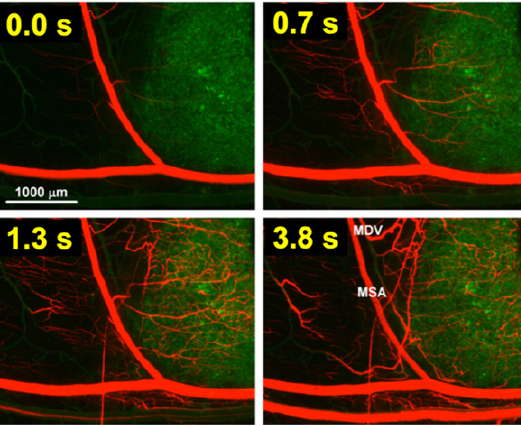
Figure 4. Tumor plasma transit time. Tumor (green fluorescent labeled cancer cells) was imaged by intravital fluorescence microscopy. A red fluorescent contrast agent was injected as bolus. The time at left upper corner of each image indicates timing relative to plasma first entering the tumor segment; plasma exits the tumor segment again within ~4 s (note: red blood cells move slower than plasma and remain longer in the tumor segment). In the final image (right lower corner), the main supplying artery (MSA), and main draining vein (MDV) of the imaged tumor segment are labeled. Figure reproduced with permission from